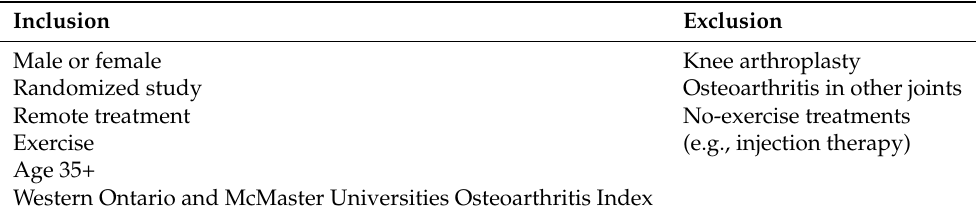
Table 1. Inclusion and exclusion